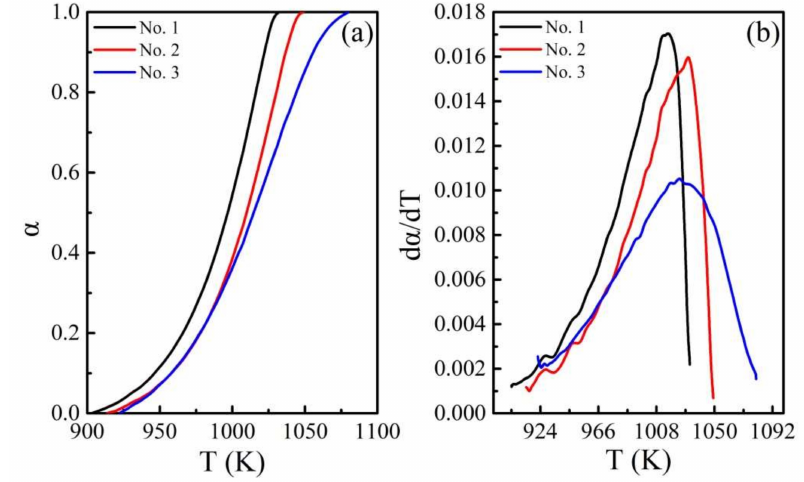
Figure 4. The conversion ( a ) rate curves ( b ) for the thermal decomposition of calcium carbonate under the argon